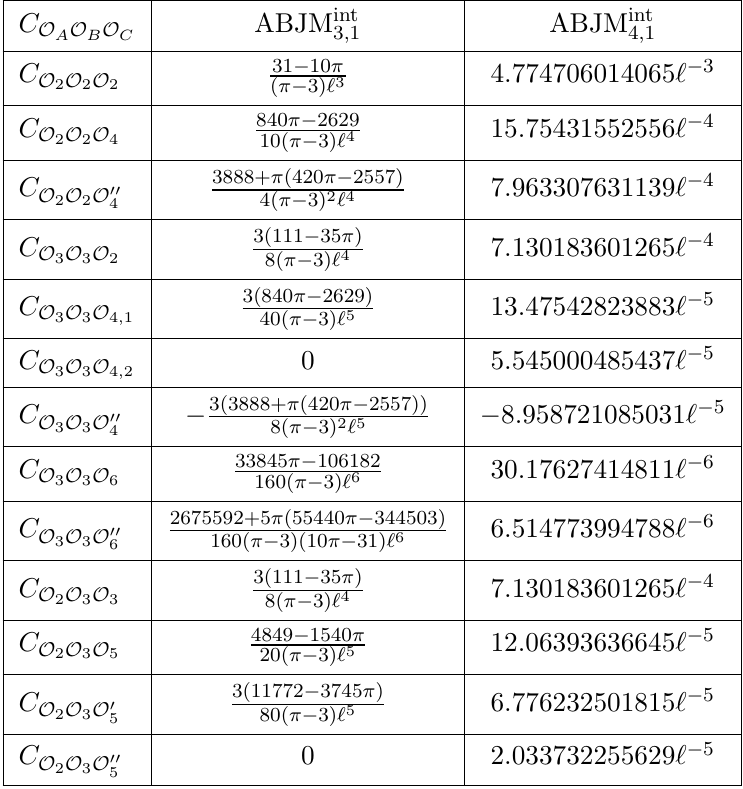
Table 6 . Values of unnormalized three-point coe(cid:14)cients in the 1d theory corresponding to super- conformal primaries in ABJM int with N = 3 ; 4. N; 1